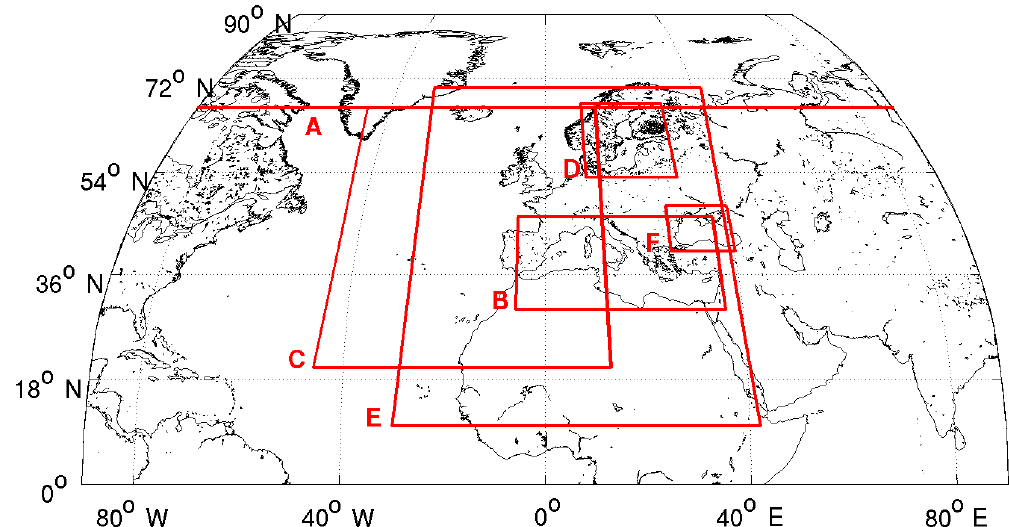
Figure 3. Map of the regional data sets (regional seas). The longitude (latitude) ranges for these regions are A for Arctic seas, 180 ◦ W– 180 ◦ E (66–90 ◦ N); B for Mediterranean Sea, 6 ◦ W–36.5 ◦ E (30–46 ◦ N); C for North Atlantic, 46 ◦ W–13 ◦ E (20–66 ◦ N); D for Baltic Sea, 9.25–30.25 ◦ E (53–66.85 ◦ N); E for European seas, 30 ◦ W–42 ◦ E (10–70 ◦ N); F for Black Sea 26.5–40.0 ◦ E (40–48 ◦